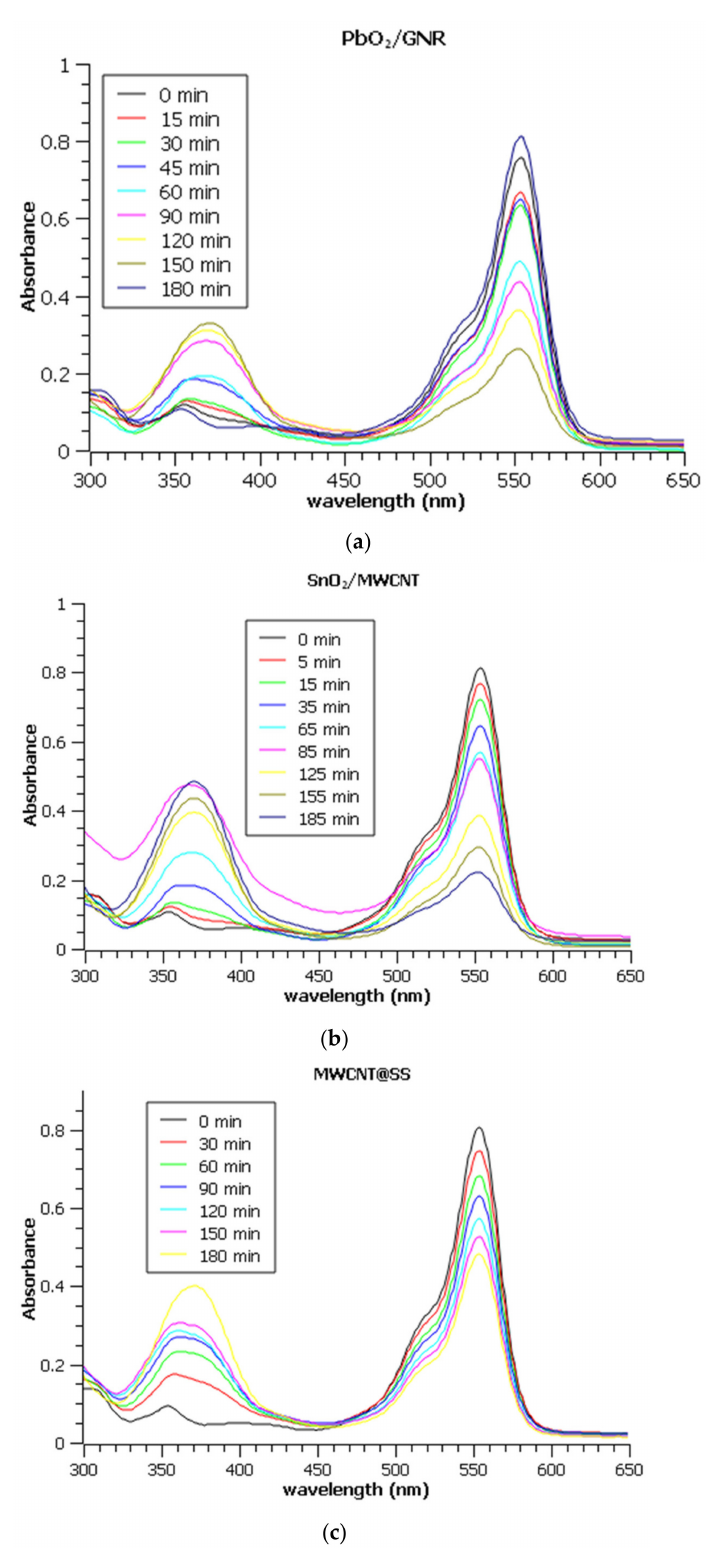
Figure 6. UV Vis absorption spectra of Rhodamine B during electrochemical degradation